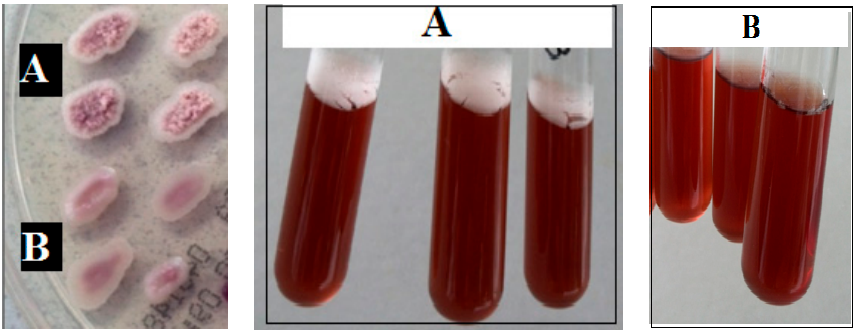
Figure 5. Yeast film from P. manshurica producing rough ( A ) or smooth ( B ) colonies inoculated in sterile olive brines.